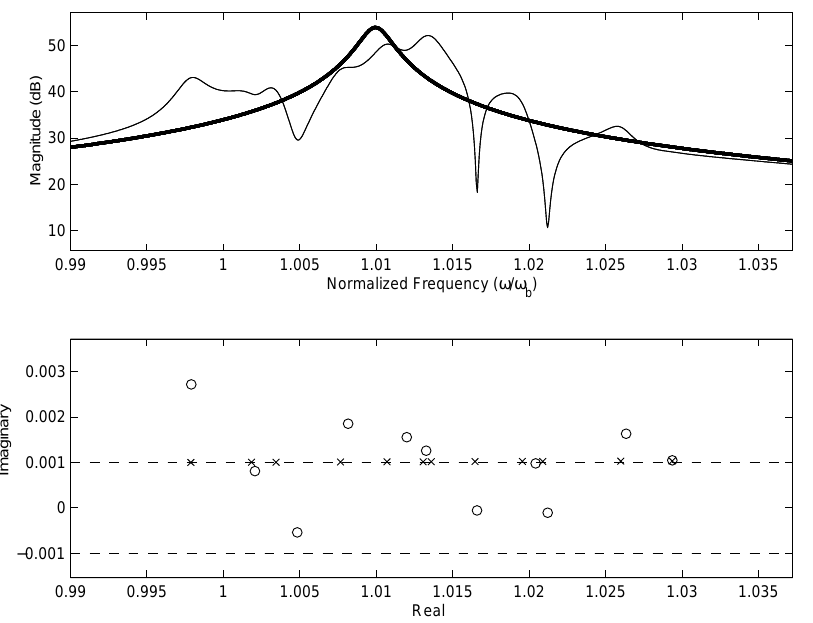
Fig. 7. Smallest Amplification Mistuning Pattern (A=0.82, E=3). a) Maximum Blade FRF. — tuned, — mistuned. b) Pole/Zero Map. × poles, ◦ zeros. Zeros between the dashed lines reduce the response more than the poles amplify it. the amount of mistuning. The closely spaced eigenval- eigenvectors change from having extended participa- ues of the tuned system “veer” away from each other tion in many blades to being more localized around one as the amount of mistuning is increased. The tuned or a few blades when mistuning is increased.